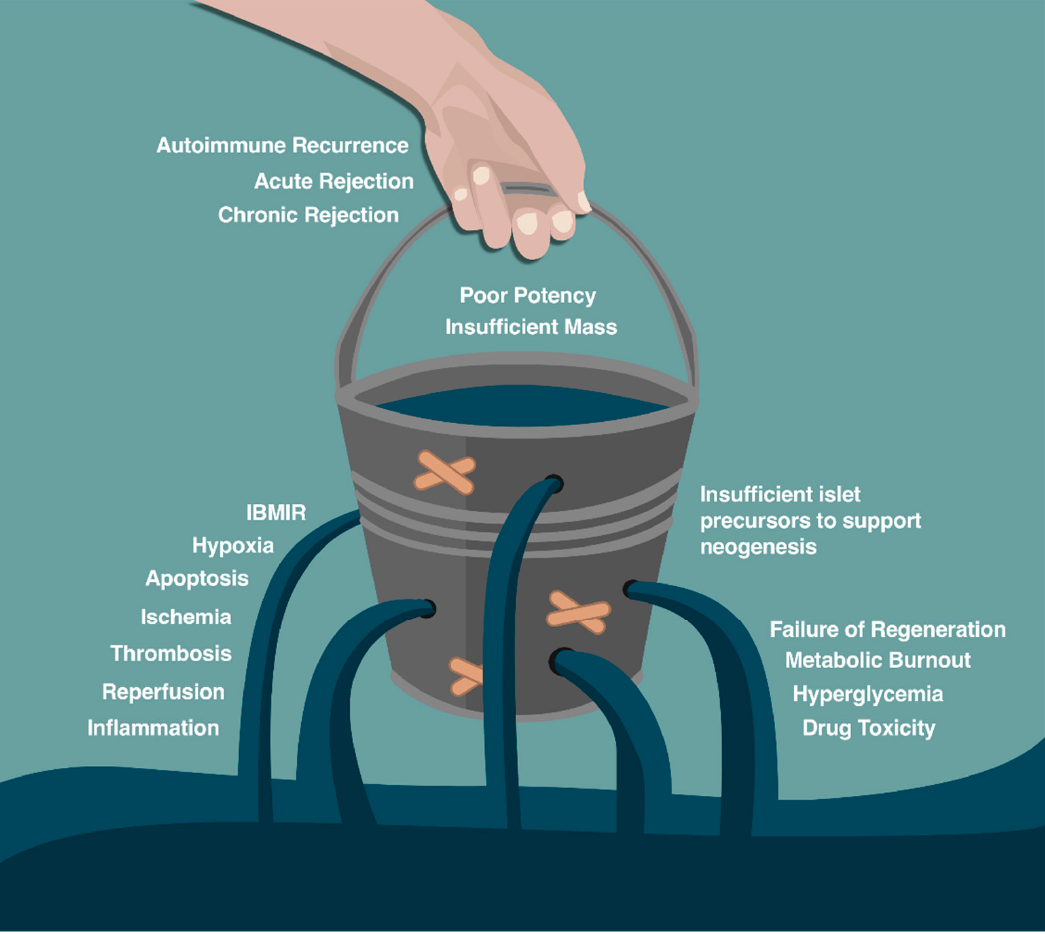
Figure 3. Limiting factors for islet cell engraftment after islet cell transplant. Adapted from Shapiro et al. (2011) with permission for reuse [11].